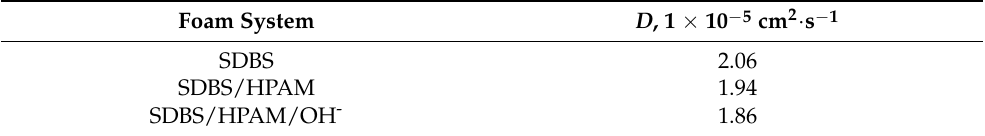
Figure 3. Mean square displacement of water molecules in the hydration shell of the liquid film in different foam systems. Table 2. Diffusion coefficients of water molecules in the hydration shell of the liquid film in different foam